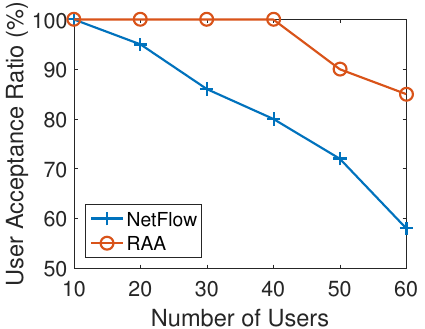
Figure 13. User acceptance ratio with non-uniform